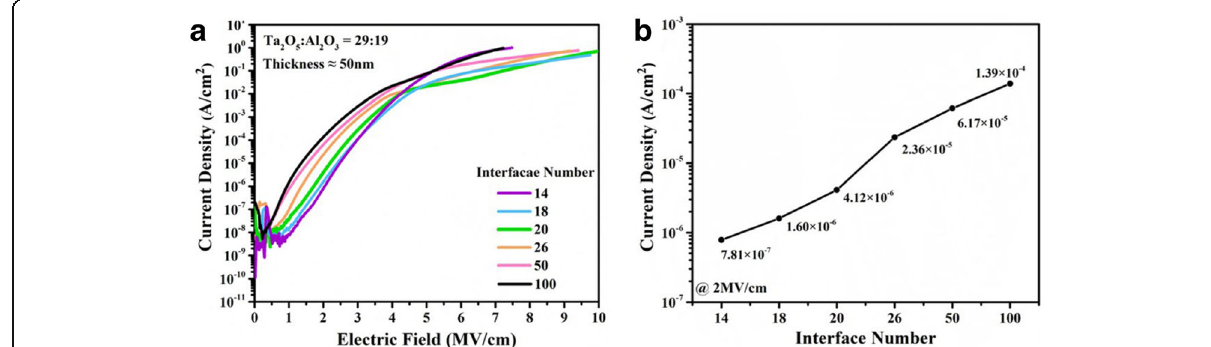
Fig. 4 a I-V behaviors and b the change of leakage current for the composite films with various the number of